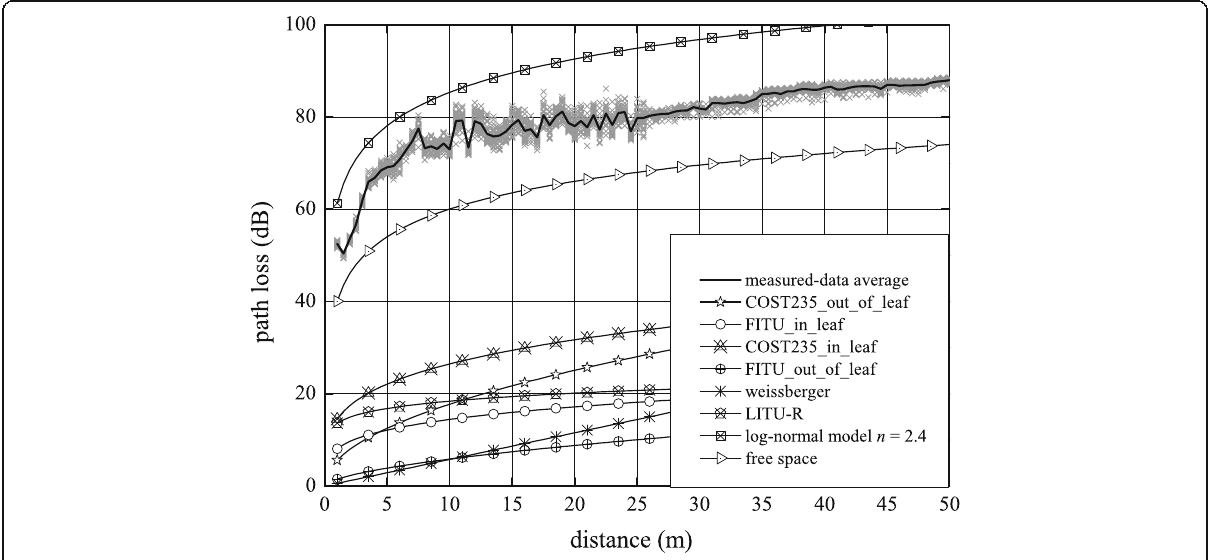
Fig. 3 Path loss obtained from measurement and prediction of the first case with antennas on the